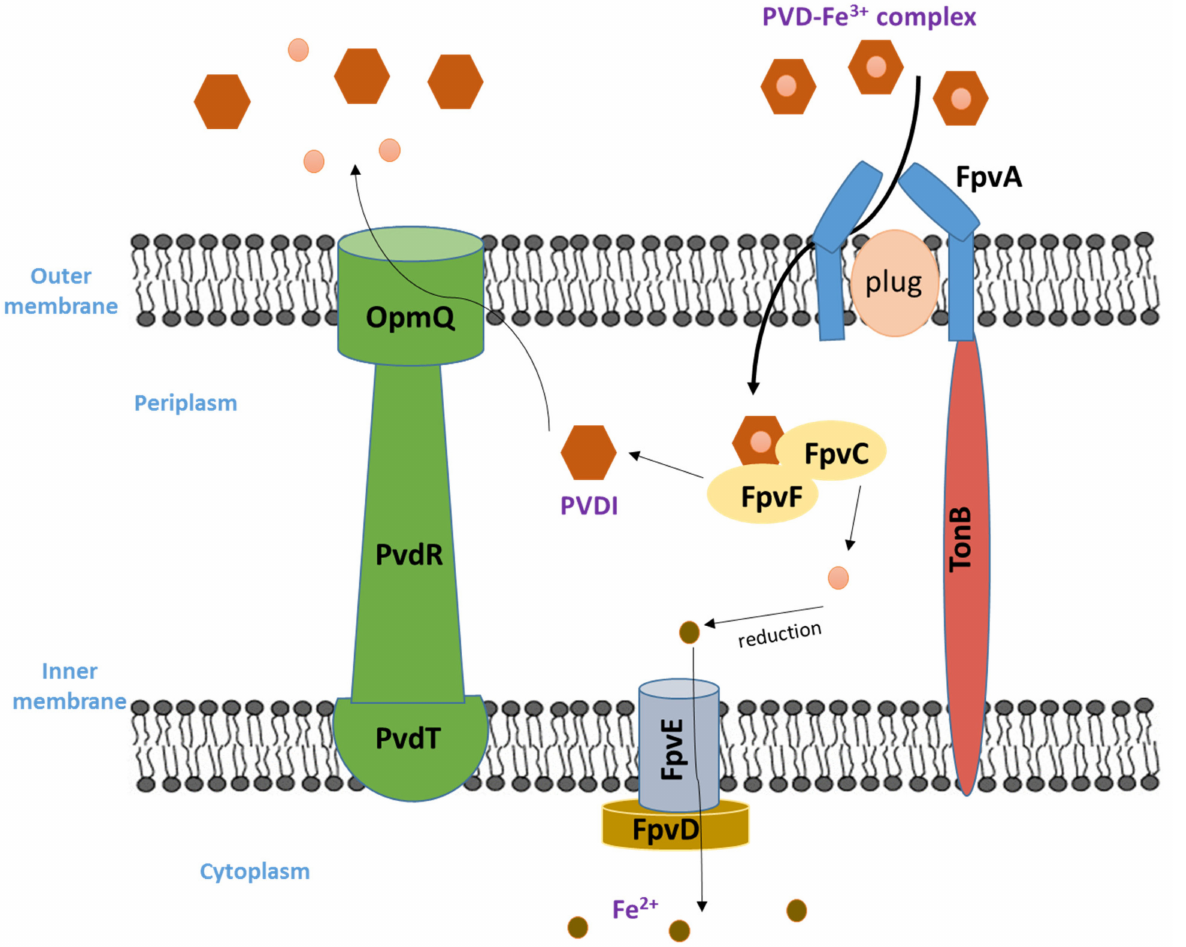
Figure 3. The pathway of iron loaded PVDs uptake and the excretion of recycled